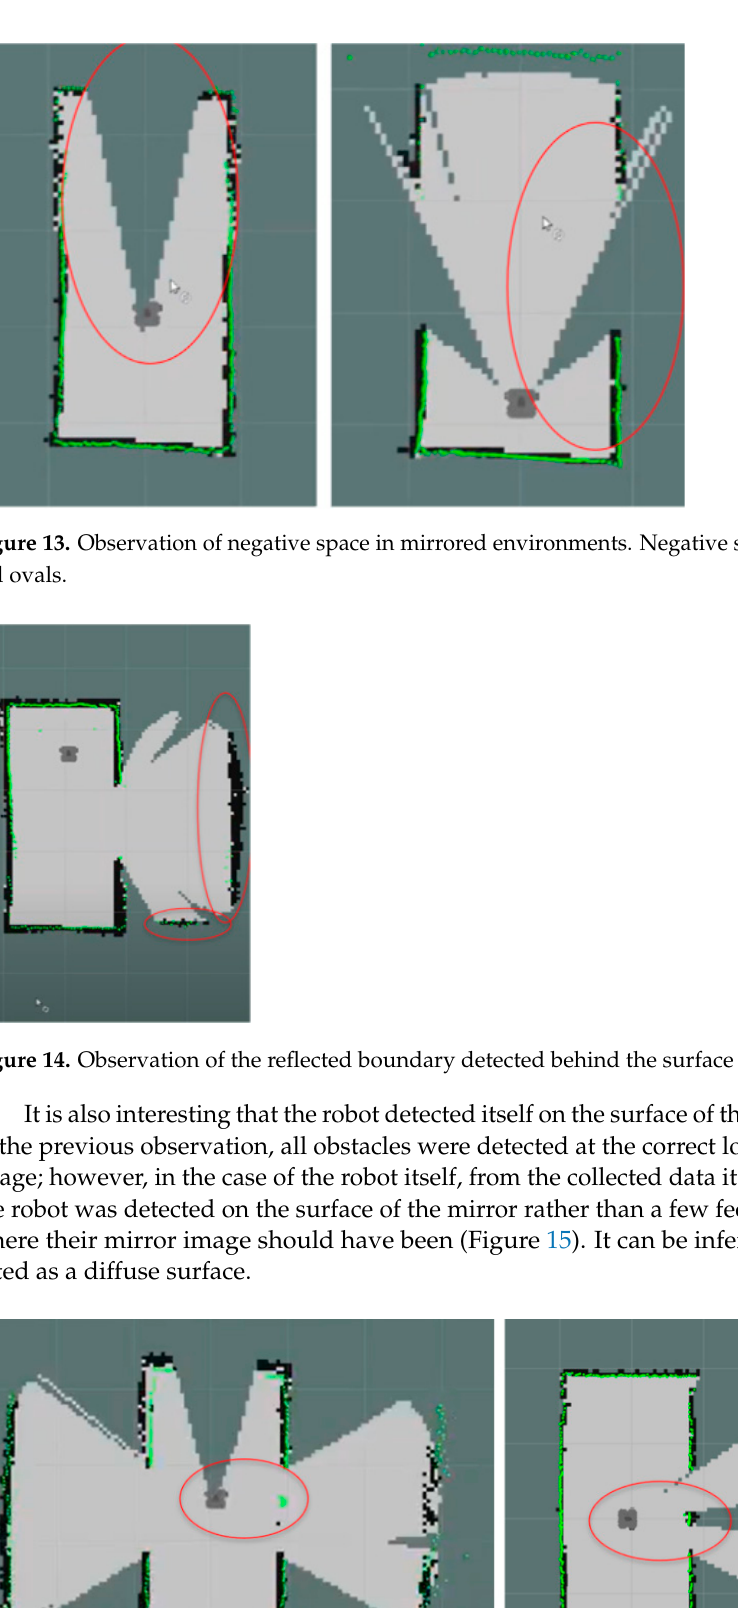
Figure 15. Observation of the robot detecting itself on the surface of the mirror.